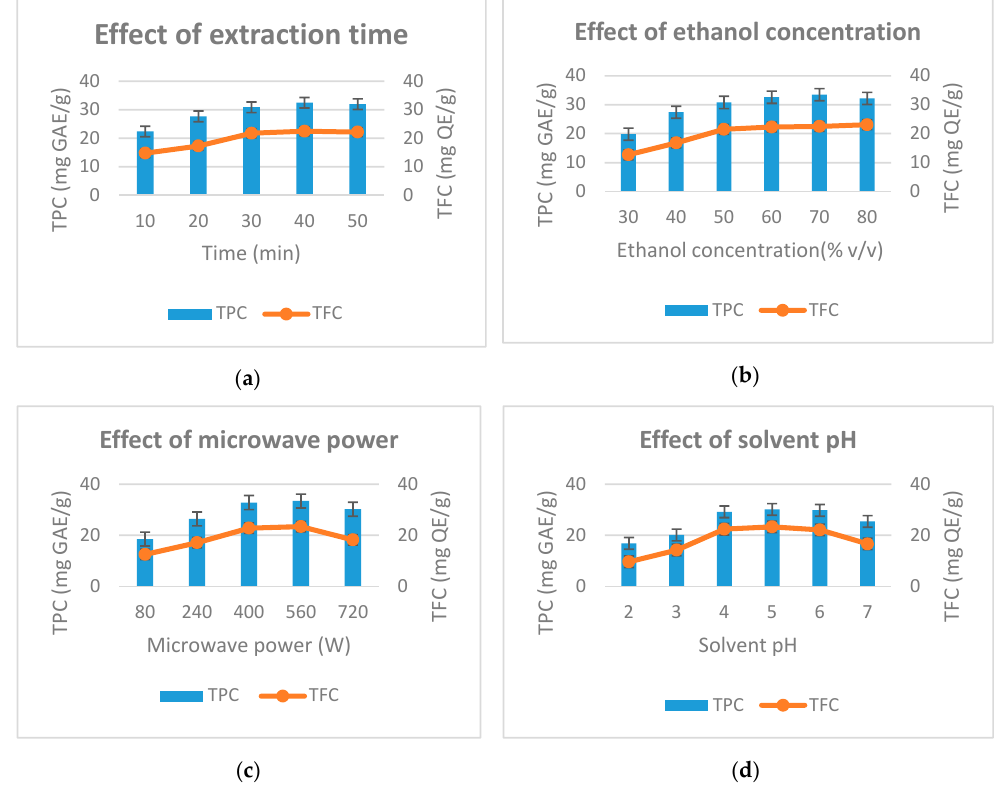
Figure 2. Effect of extraction time ( a ), ethanol concentration ( b ), microwave power ( c ) and solvent pH ( d ) to the total phenolic and total flavonoid from D.indica.